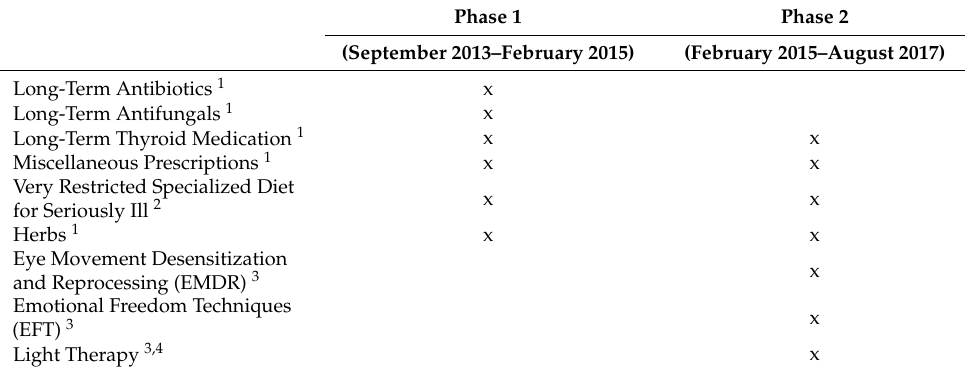
Table 5. Summary of Treatments Used by Patient Over 4+ Year